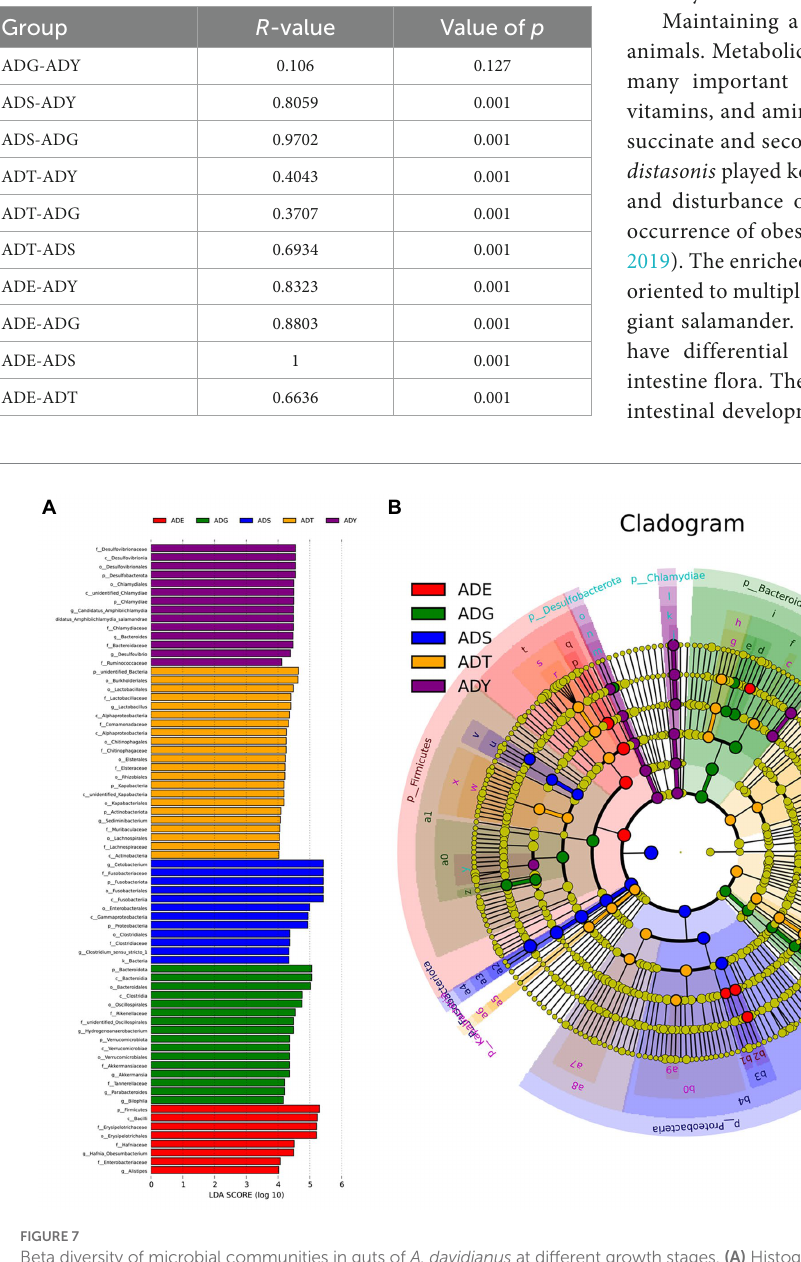
TABLE 3 ANOSIM of community structure differences between